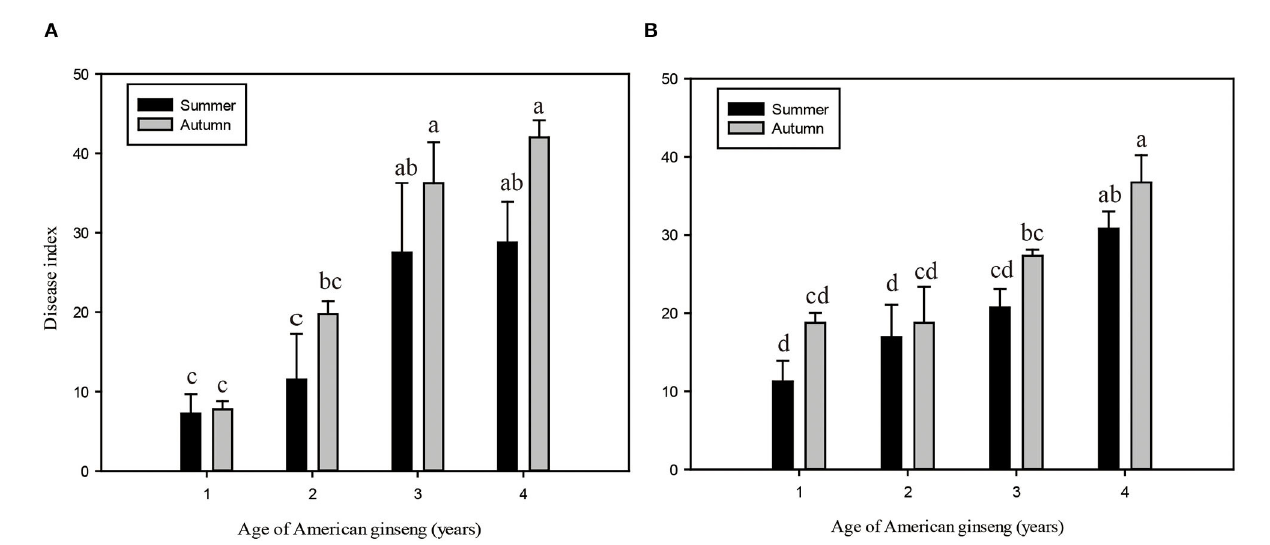
FIGURE1 Root disease index of American ginseng of different ages in summer and autumn of Dashuipo in 2017 (A) and Zetou in 2018 (B) . Error bars represent standard errors of four replicates, and different letters indicate a significant difference among different ages of ginseng ( P < 0.05, according to Duncan’s multiple range